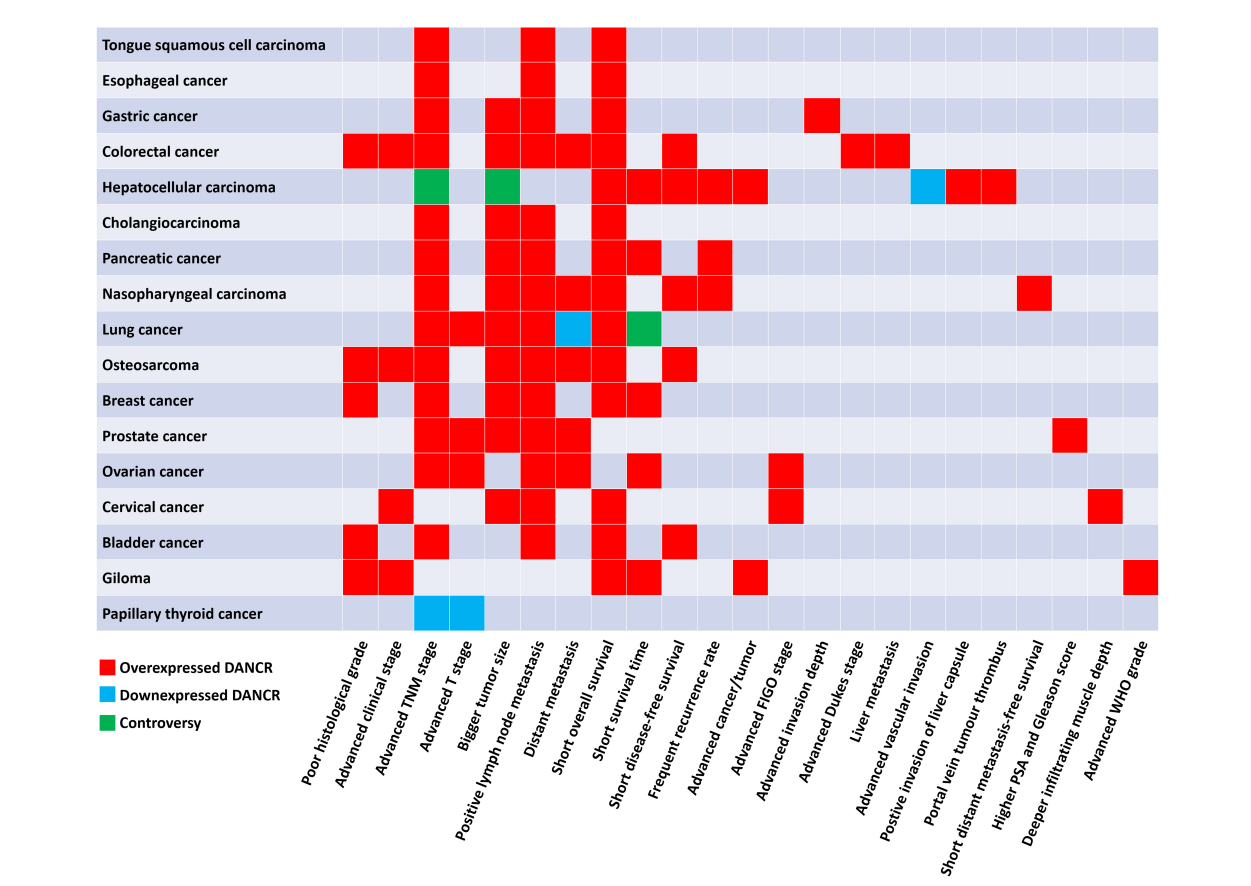
FIGURE 3 | The correlation of DANCR expression level with clinicopathological factors of patients with